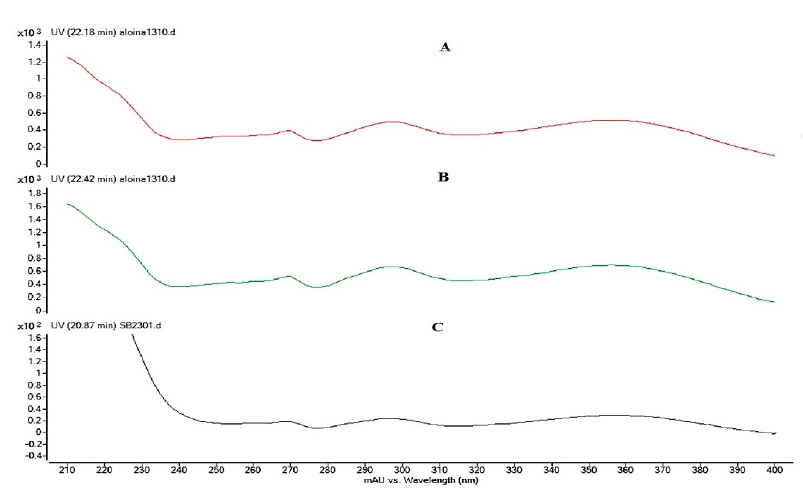
Figure 3. UV spectrum of Aloin A ( A ), Aloin B ( B ), and EA ( C ) with a wavelength of 350 nm.